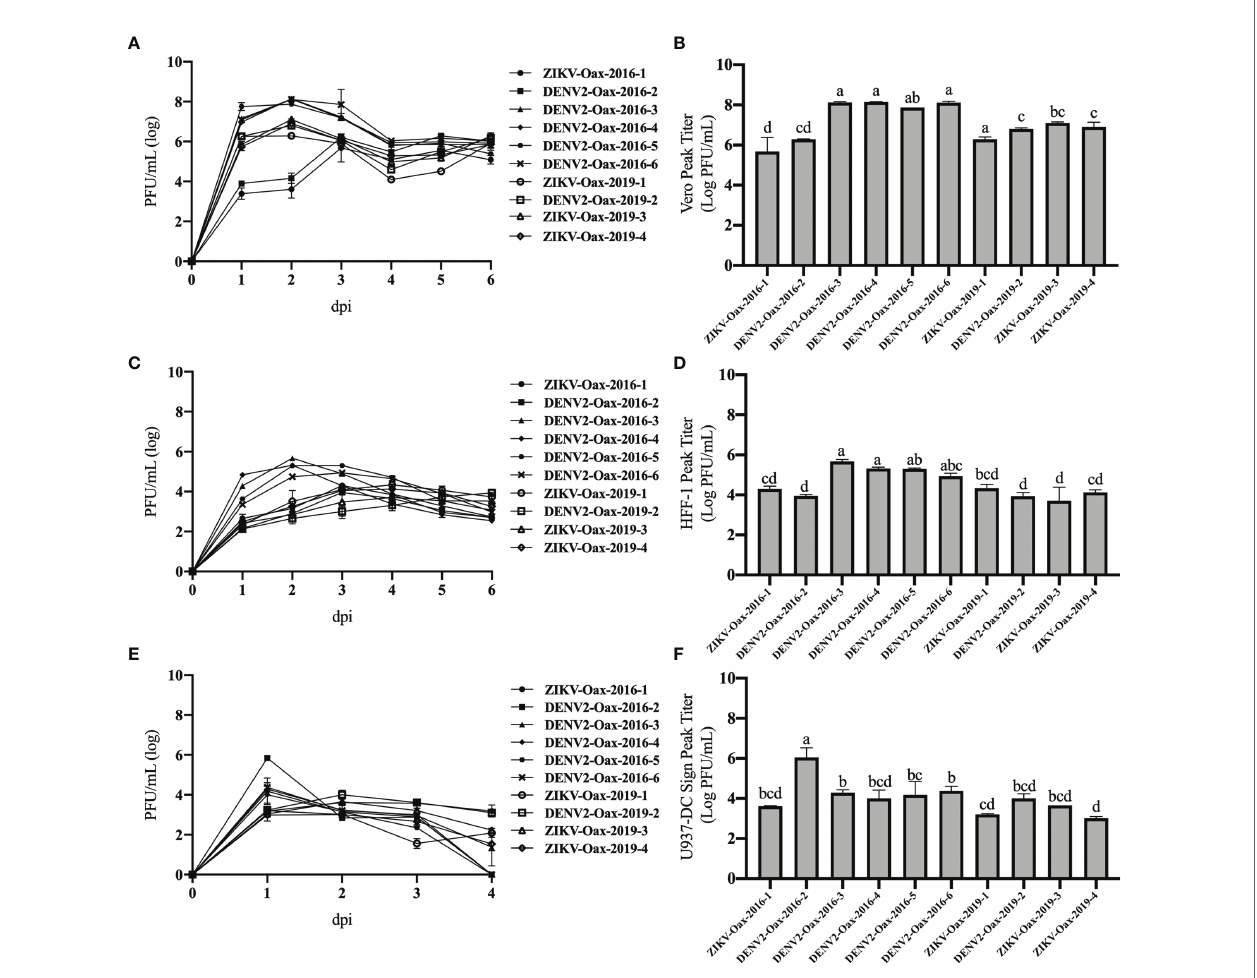
FIGURE 2 | Replication curves of Flavivirus isolates. Multistep growth curves were performed in Vero (A) , HFF-1 (C) , and U937 DC-SIGN cells (E) infected at a multiplicity of infection (MOI) of 0.1 with the indicated Flavivirus isolates and harvested from 1 to 6 days post-infection. Titers were obtained in Vero cells and are plotted on a logarithmic scale. Peak titers obtained by each isolate in Vero (B) , HFF-1 (D) , and U937 DC-SIGN cells (F) are presented. Letters indicate distinct groups based on the post-hoc statistical comparison (p < 0.05). Groups without a common letter are signi fi cantly different. Data are presented as the mean ± SD; n =